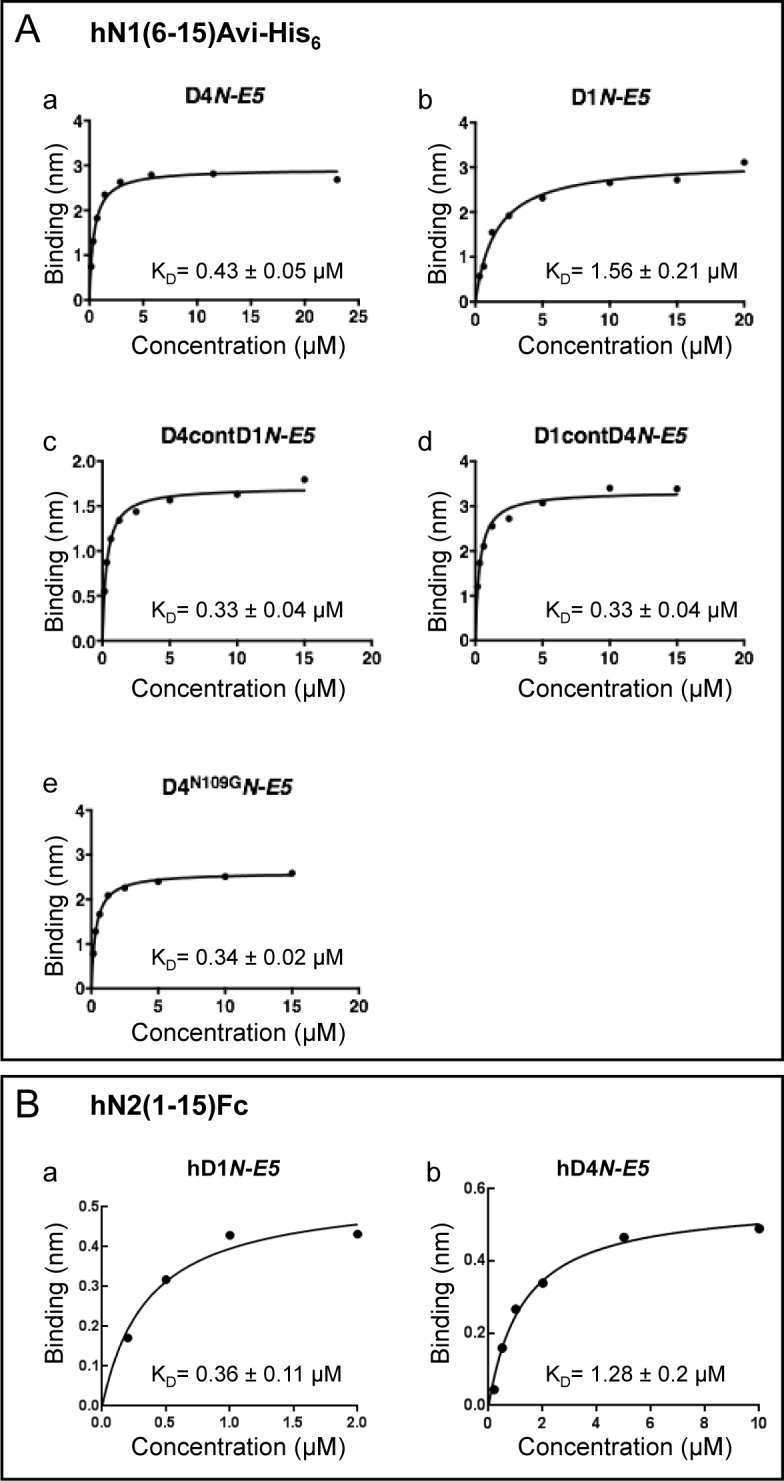
Analysis of ligand receptor binding.(A) Analysis of the binding of various ligands to a biotinylated human N1 ectodomain fragment containing EGF repeats 6–15 using biolayer interferometry. Binding of DLL4 (from the N-terminus through EGF-repeat 5; (a), DLL1 (from the N-terminus through EGF-repeat 5; b), D4contD1 (c), D1contD4 (d), or D4N109G (e) to the N1 fragment was measured after the N1 fragment was immobilized on a streptavidin sensor tip. The data were analyzed using a single-site binding model using GraphPad Prism software. Calculated KD values and SEM are shown below the graphs. (B) Analysis of DLL1 and DLL4 binding to human N2 using biolayer interferometry. Detection of DLL1 (from the N-terminus through EGF-repeat 5; (a) or DLL4 (from the N-terminus through EGF-repeat 5; (b) binding to N2(1–15)-Fc immobilized on a protein A sensor tip. The data were analyzed using a single-site binding model using GraphPad Prism software. Calculated KD values and SEM are shown below the graphs.